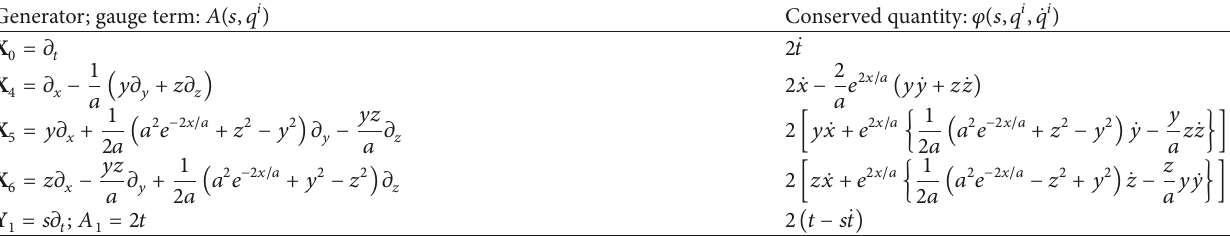
Table 13: Conserved quantities corresponding to each Noether symmetry.